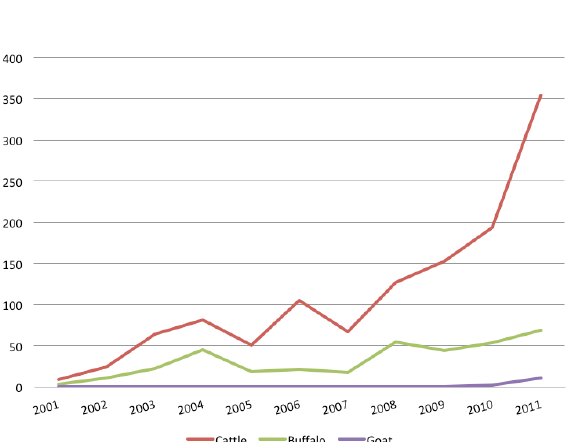
Figure 3. Human casualties (Deaths and Injuries) from 2001 to 2011